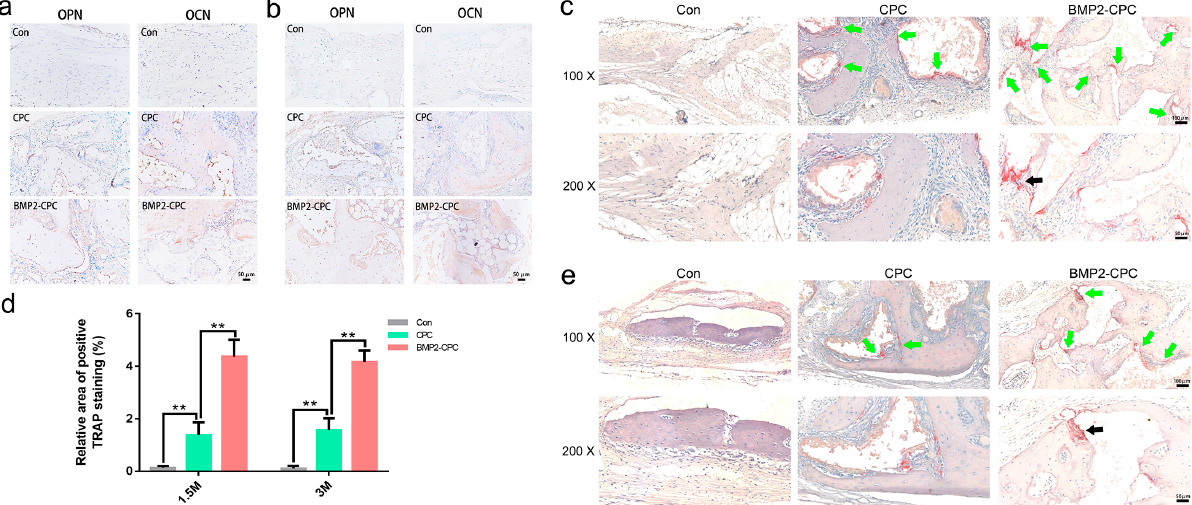
Figure 6. Immunohistochemical staining and TRAP staining results. ( a ) Representative immuno- histochemical staining images of OPN and OCN in each group (200 × , 1.5 months after surgery); ( b ) representative immunohistochemical staining images of OPN and OCN in each group (200 × , 3 months after surgery); ( c ) 1.5-month TRAP staining results of each group; ( d ) quantification of the area of positive TRAP staining in the defects in each group; ( e ) 3-month TRAP staining results of each